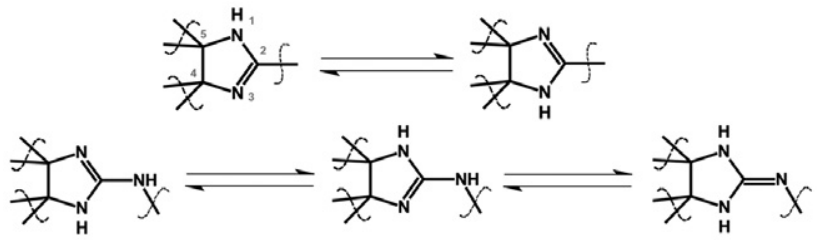
Figure 2. Tautometry of imidazoline and 2-2-iminoimidazoline rings (Bajpai & Tyagi, 2008)